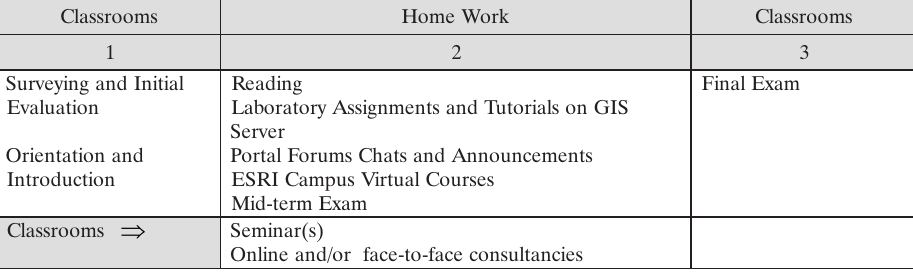
Fig. 4. Structure and sequence of the course delivery